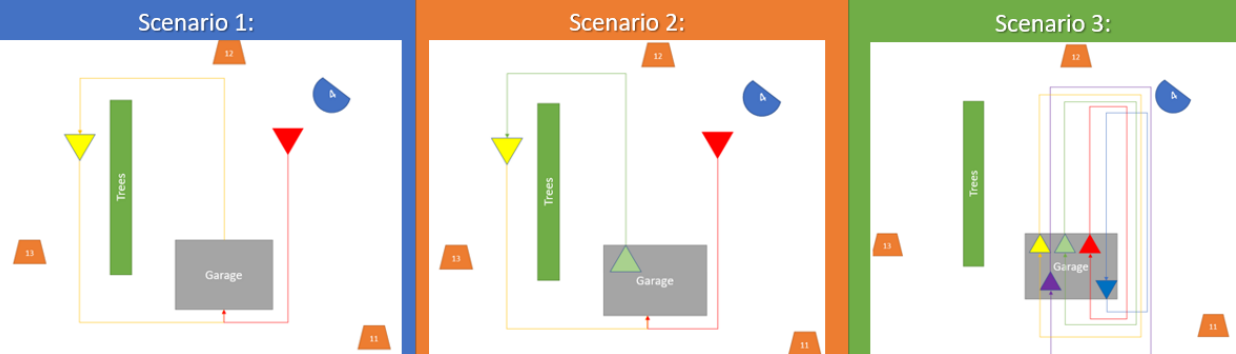
Figure 1. Scenarios 1, 2, and 3. In Scenario 1, Vehicle 2 (the yellow triangle) attempts to hide behind the treeline, while Vehicle 1 (the red traingle) drives around the garage. In Scenario 2, a third vehicle (the green triangle) attempts to “substitute” itself for Vehicle 2 after Vehicle 2 enters the garage. In Scenario 3, there is a shuffle as multiple vehicles, including 4 and 5 (the purple and blue triangles, respectively) begin to shuffle as they drive around and enter the